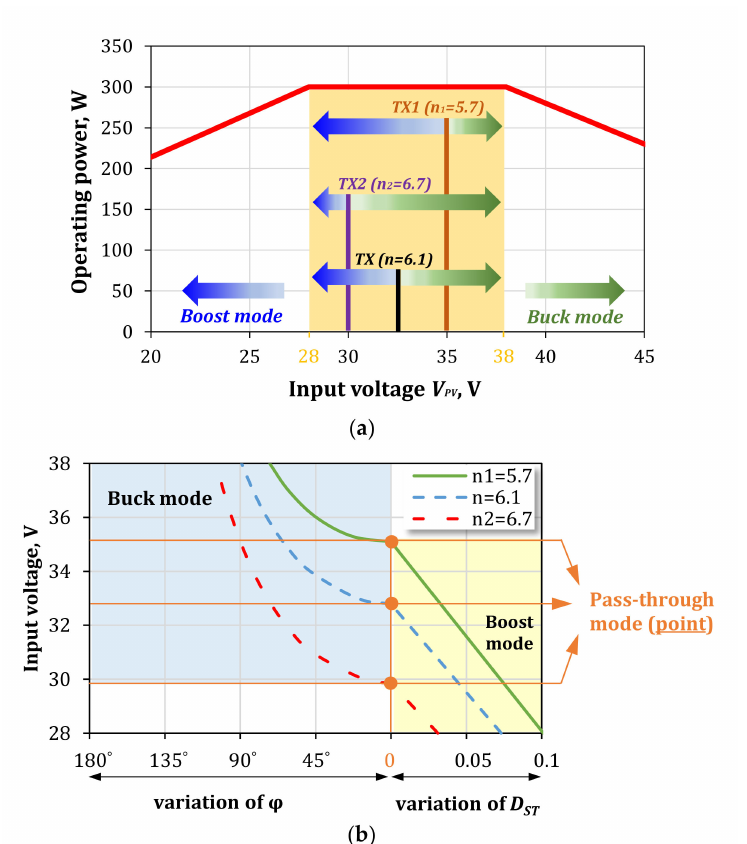
Figure 4. Impact of the turns ratio of the isolation transformer on the multimode control ( a ) and control variables ( b ) of qZS IBBC within the predefined voltage range: balanced buck–boost operation with the baseline transformer TX ( n = 6.1), dominance of the boost mode with sample TX1 ( n 1 = 5.7), and dominance of the buck mode with sample TX2 ( n 2 =